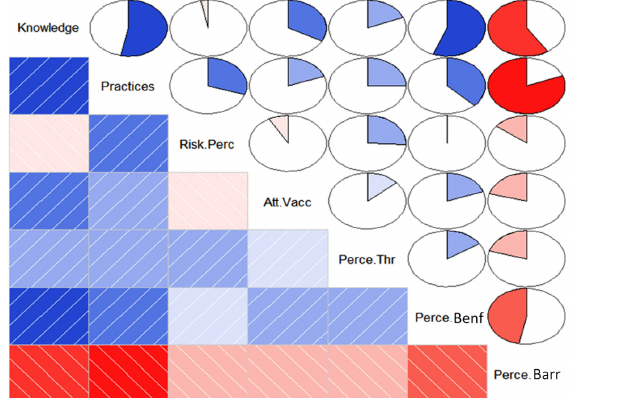
Figure 2. Correlation Matrix Between Percentage Scores of Different Elements of KAP. Blue color signifies positive correlation; Red color signifies negative correlation; The darker the color (more complete circle), the more significant the correlation